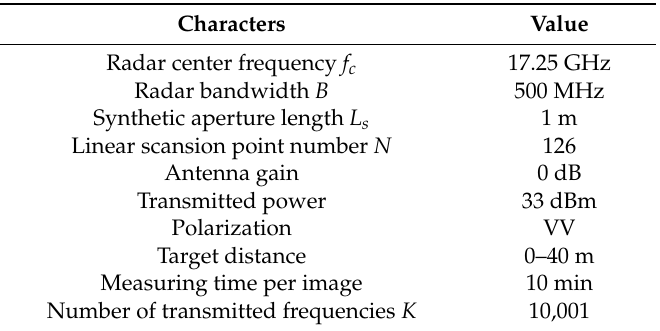
Table 2. GB-SAR Interferometer